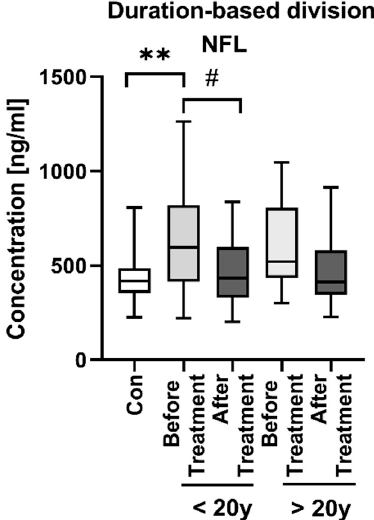
Figure 7. NFL concentrations in subgroups of patients after division according to the duration of the dermatosis (less or more than 20 years) with division before and after the treatment. ** means statistically significant difference between the patients before the treatment and controls with p < 0.01. # means statistically significant difference between the patients before and after the treatment with p < 0.05.